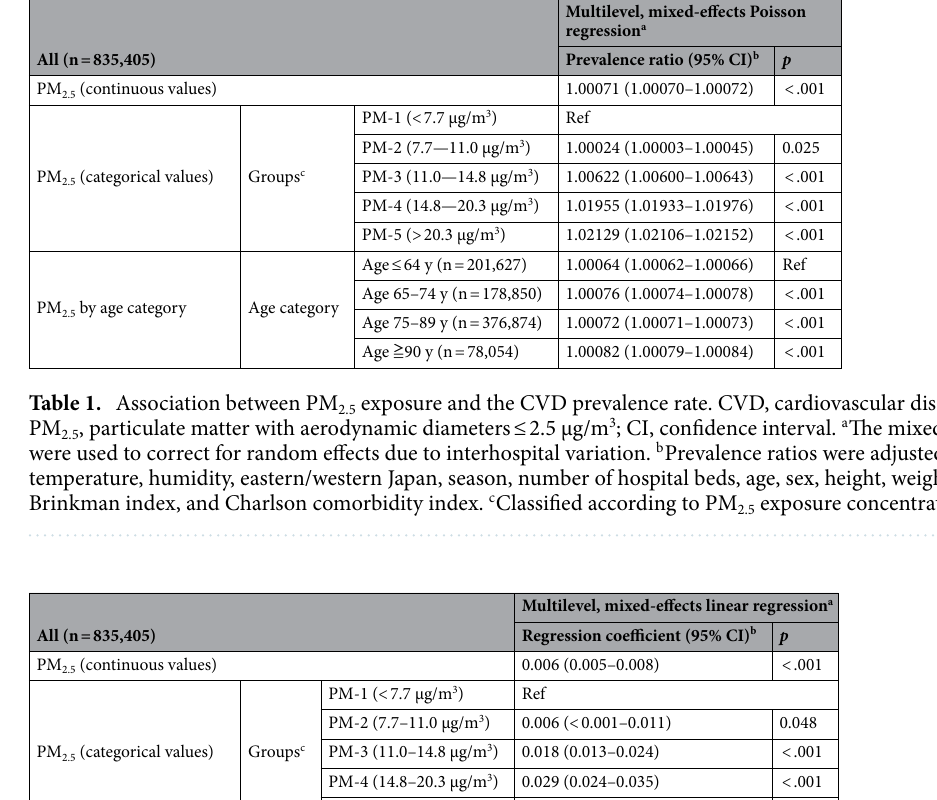
Table 2. Association between PM 2.5 exposure and lengths of CVD-related hospital stays (log days). CVD, cardiovascular disease; PM 2.5 , particulate matter with aerodynamic diameters ≤ 2.5 µm; CI, confidence interval. a The mixed model was used to correct for random effects due to interhospital variations. b Regression coefficients were adjusted for temperature, humidity, eastern/western Japan, season, number of hospital beds, age, sex, height, weight, Brinkman index, Charlson comorbidity index, angina pectoris, acute myocardial infarction, heart failure, atrial fibrillation/flutter, aortic disease, cardiac arrest, pulmonary embolism, pulmonary hypertension, and tetralogy of Fallot. c Classified according to PM 2.5 exposure concentration.